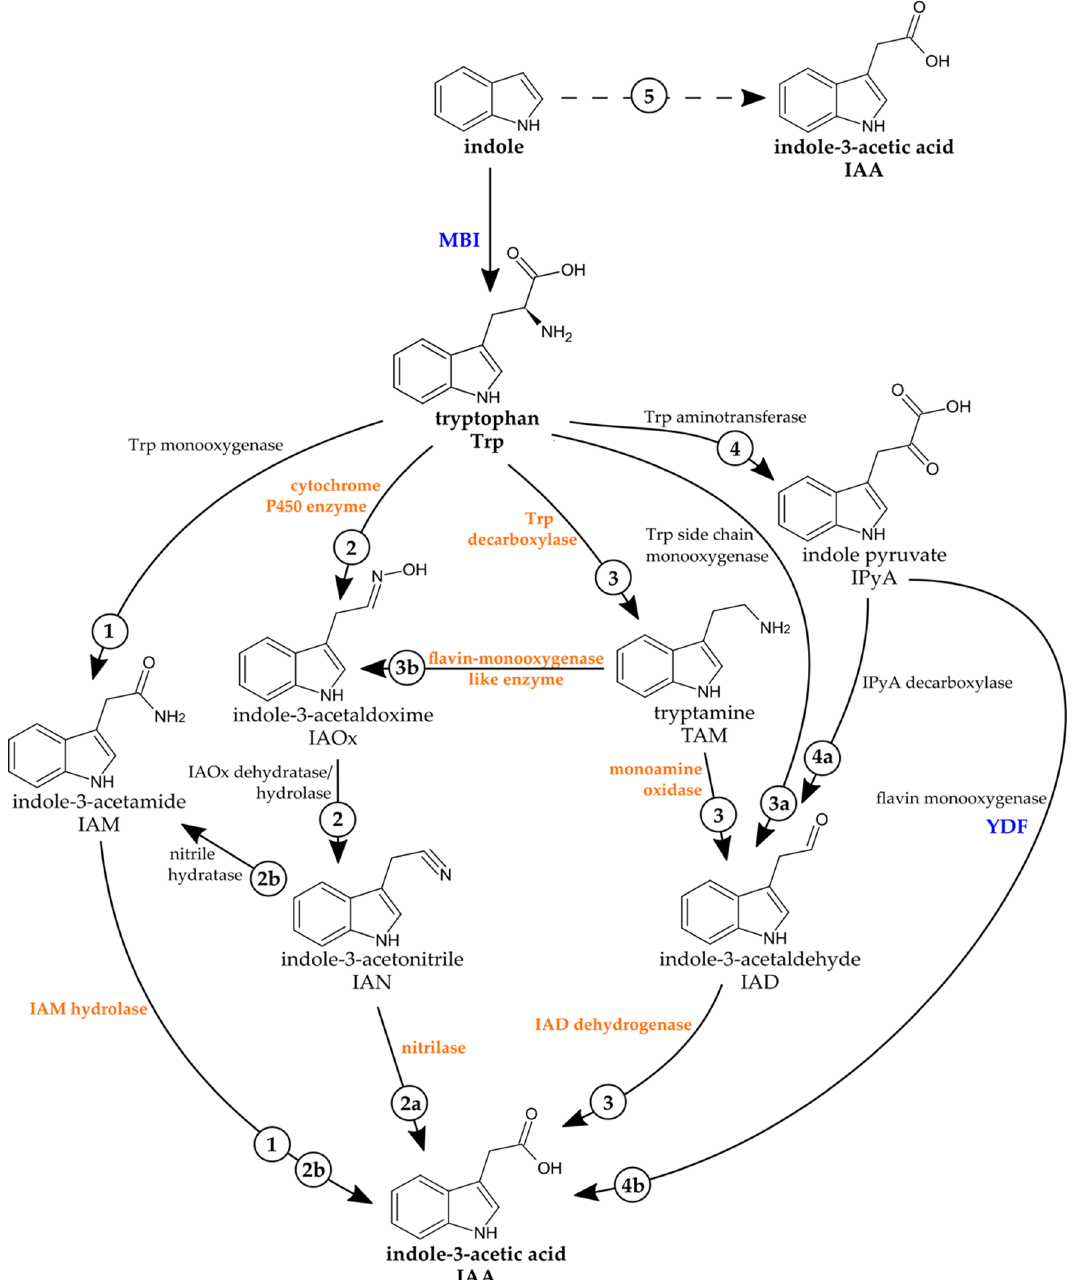
Figure 1. Indole-3-acetic acid (IAA) biosynthesis pathways in bacteria, fungi, and plants with the known enzymes (modified after KEGG [36–38]). IAA can be synthesized from tryptophan (Trp-dependent pathways, 1–4) and directly from indole (Trp-independent pathways, 5). Plants synthesize IAA over the indole-3-acetamide (IAM) (1), the indole-3-acetaldoxime/indole-3-acetonitrile (IAOx–IAN) (2-2a), the tryptamine (TAM) (3-3b-2-2a), and the indole-3-pyruvic acid (IPyA) pathway (4-4a-3 or 4-4b). Bacteria and fungi prefer the IAM (1), the IAOx–IAN (2-2a or 2-2b), the TAM (3), or the IPyA (4-4a-3) pathway. The IAA pathway with the direct conversion of Trp to indole-3-acetaldehyde (IAD, without IPyA as intermediate, 3a-3) is only known in Pseudomonas species [39–42]. The reaction site of the IAA biosynthesis inhibitors 2-mercaptobenzimidazole (MBI) (Trp synthase) and yucasin DF (YDF) (YUC enzymes) is shown in blue. Enzymes for which candidate genes were found in C. asteris are highlighted in orange (see also Table 1).